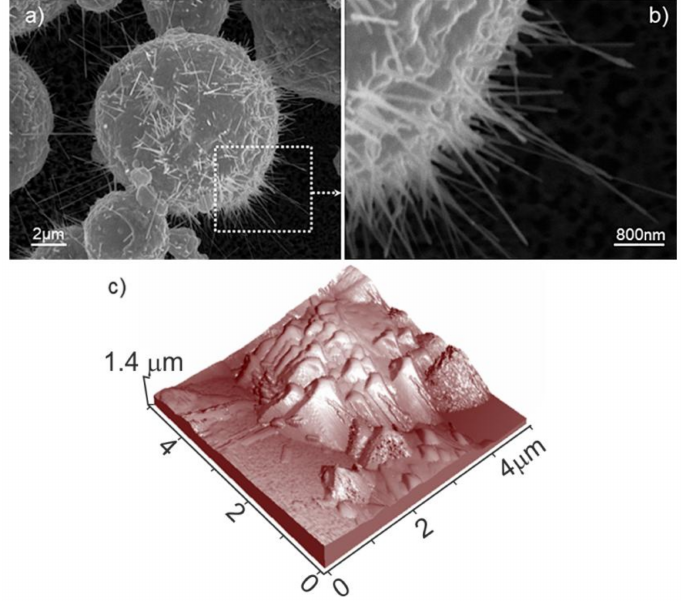
Figure 7. SEM image of ( a ) ZnO spherical cages grown on Pt thick film (50 nm thick) at 700 ◦ C for 3 h, ( b ) enlarged view of ( a ), ( c ) three-dimensional (3D) non-contact AFM (5 × 5 µ m) image of a region of a ZnO spherical